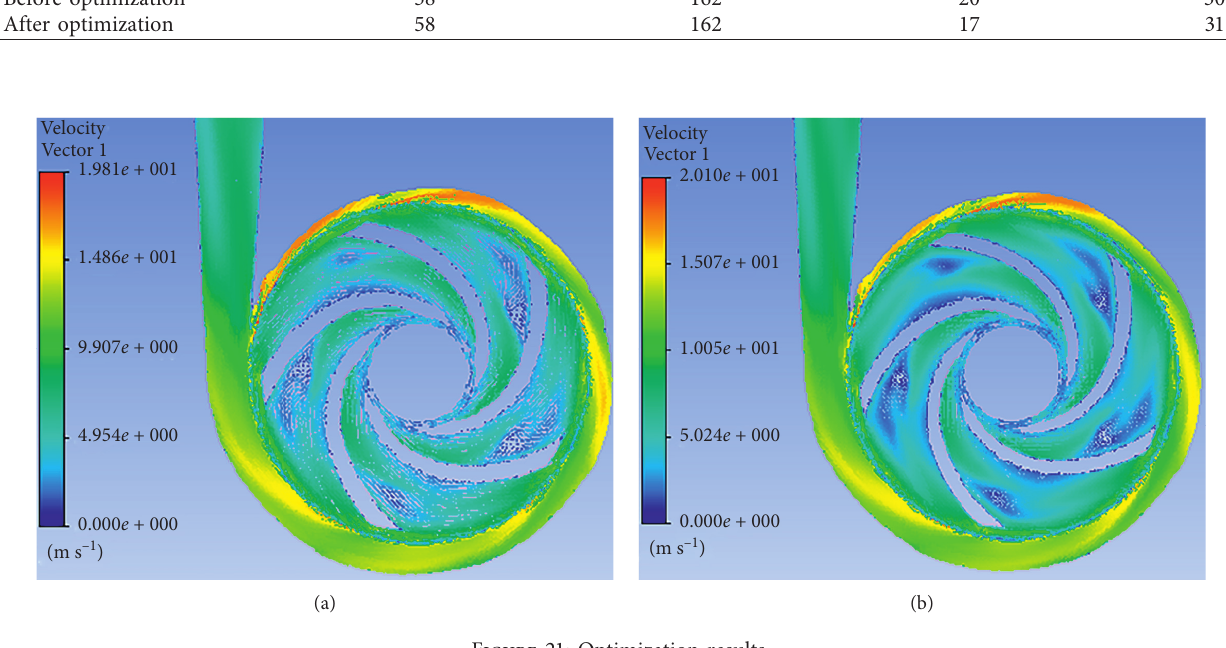
Figure 21: Optimization